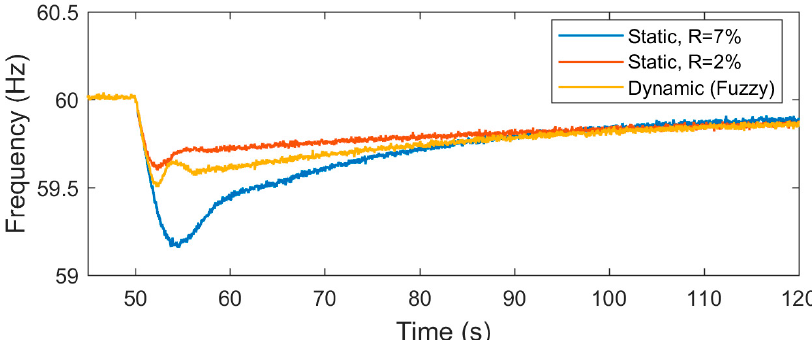
Figure 8. Grid frequency (large ROCOF).